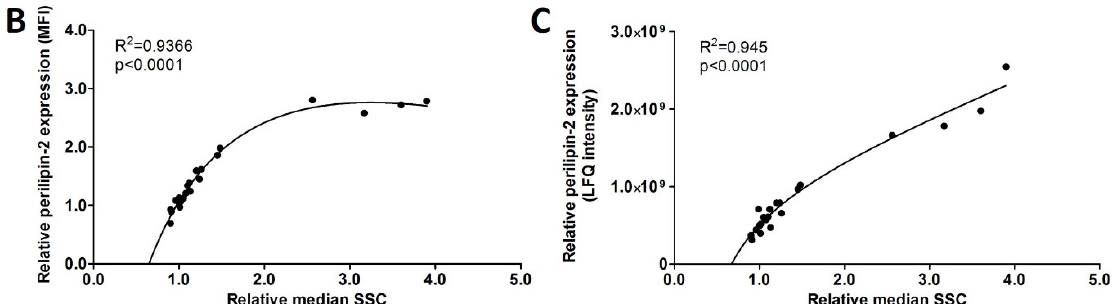
Figure 4. FSGS plasma-induced perilipin-2 expression is correlated with granularity in hPod. ( A ) Granularity as measured by flow cytometry side scatter (SSC). Median SSC of two replicate experiments and their means relative to healthy plasma are depicted. Circles represent controls, squares active disease FSGS plasmas, and triangles (partial) remission plasmas. * p < 0.05, *** p < 0.001 compared to healthy plasma. ( B ) Correlations of median perilipin-2 fluorescence intensities (MFI) from Figure 2B with the relative median side scatter (SSC) from ( A ). Non-linear fit equation: Y = 12.13 × X/(0.9694 + X) − 0.6616 × X − 4.429. ( C ) Correlations of median perilipin-2 LFQ intensities from Figure 2A with the relative median side scatter (SSC) from ( A ). Non-linear fit equation: Y = 8.043 × 10 10 × X/(0.0093 + X) + 4.319 × 10 8 × X − 7.963 × 10 10 . FCS: fetal calf serum; healthy: pooled plasma from five